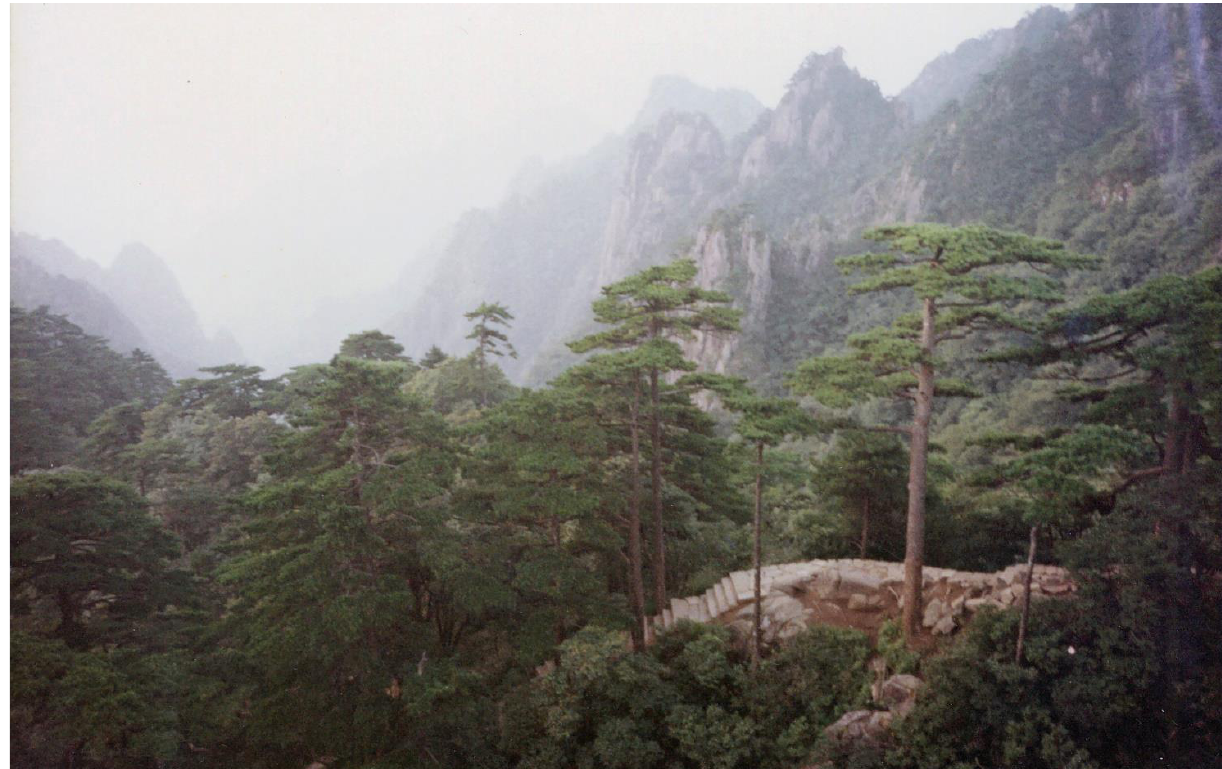
Figure 20. Archival, undated photographs of Mount Huangshan by Liu Kang. Liu Kang family collection. Images courtesy of Liu family.